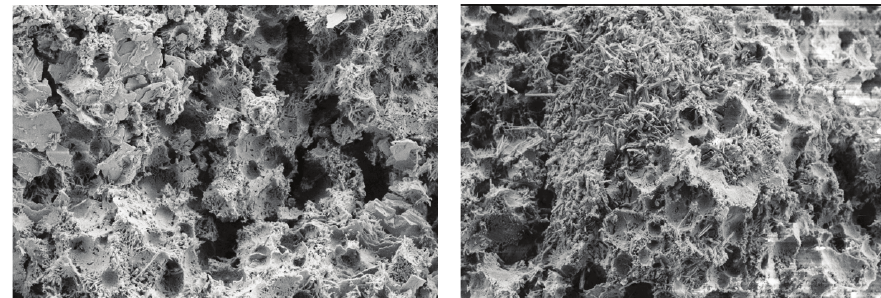
Figure 11: Microstructure of cement hydrates after elimination of asphalt.